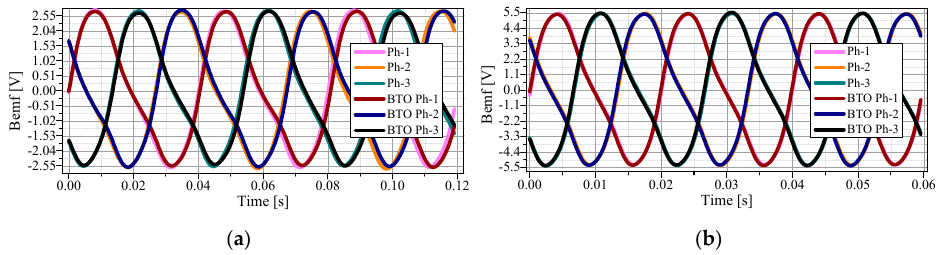
Figure 10. BEMF of the motor with and without rotor BTO layer. ( a ) BEMF at 1000 r / min. ( b ) BEMF at 2000 r / min.